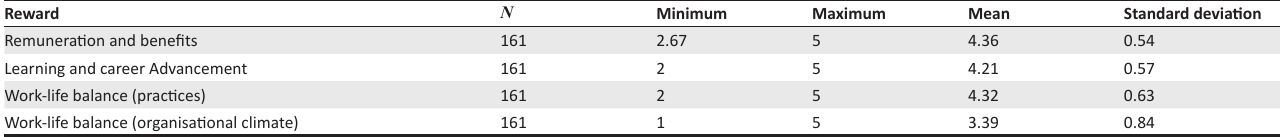
TABLE 5: Descriptive statistics of the total reward elements.